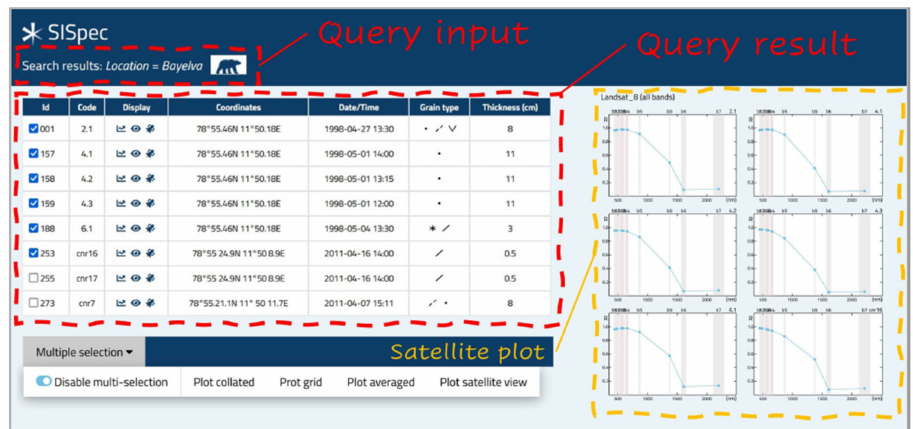
Figure 7. Results of the query by location and spectrum for the Bayelva sites. Example of band resampling considering the sensors deployed on the Landsat 8 platform. Information sections rearranged for